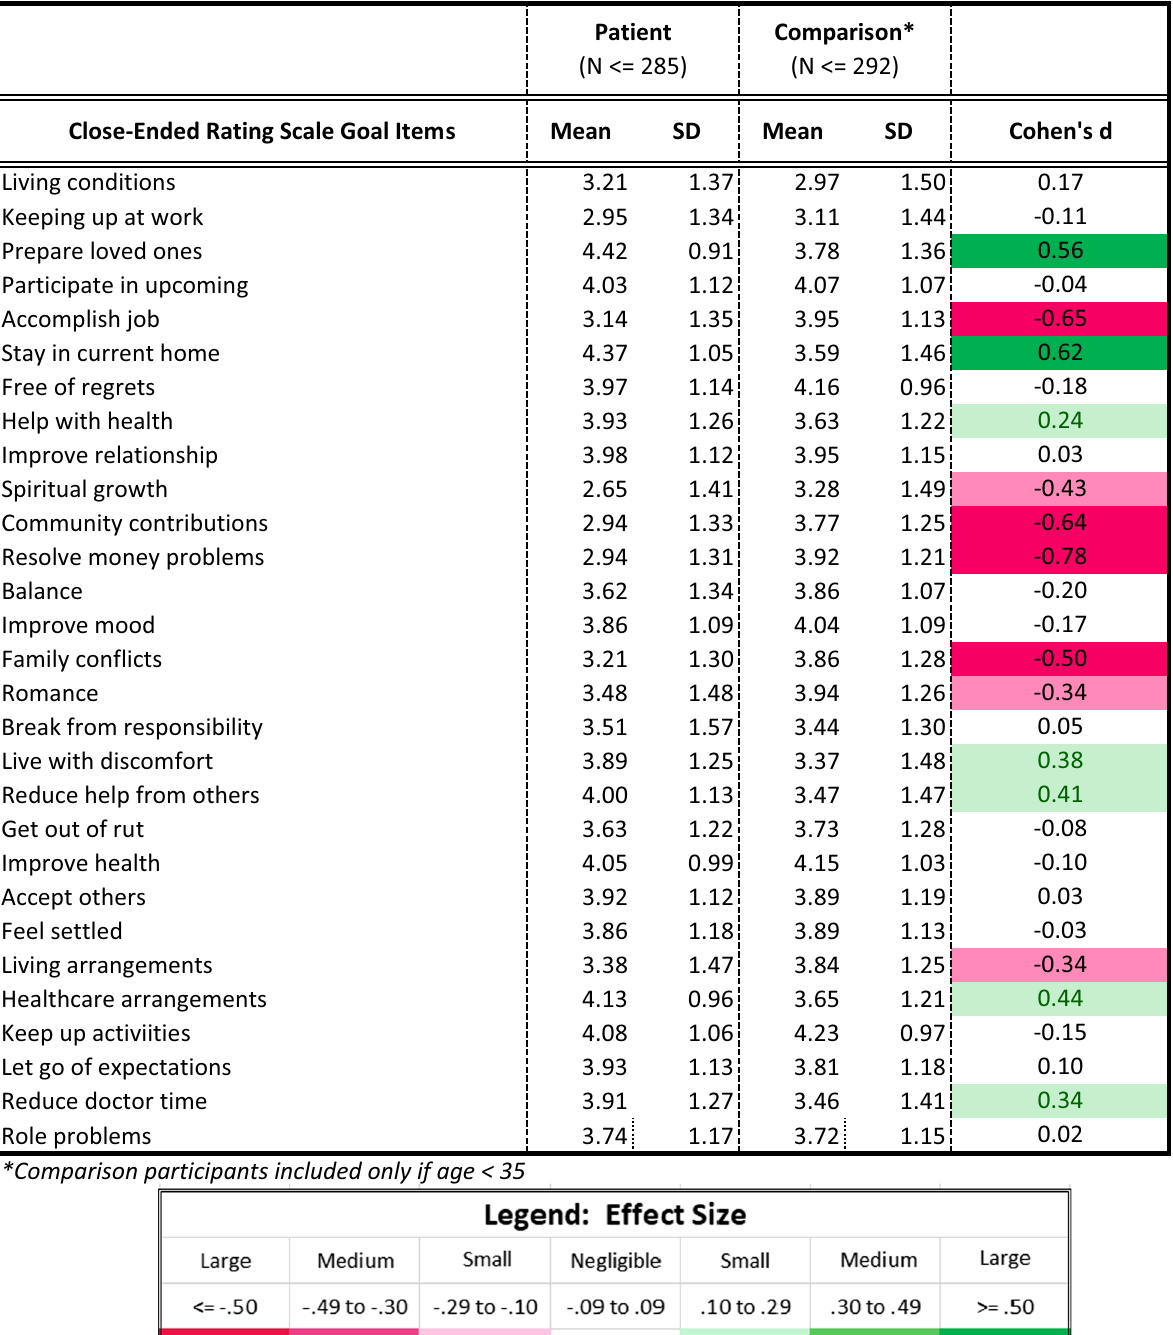
Table 3 Descriptive statistics for close-ended goal items